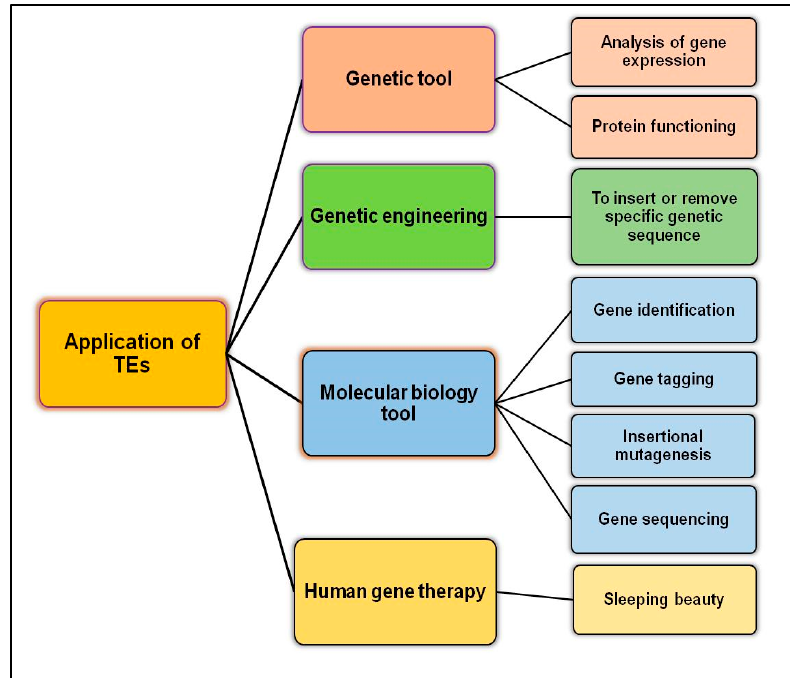
Figure 4. Potential applications of TEs in biological science and human health.